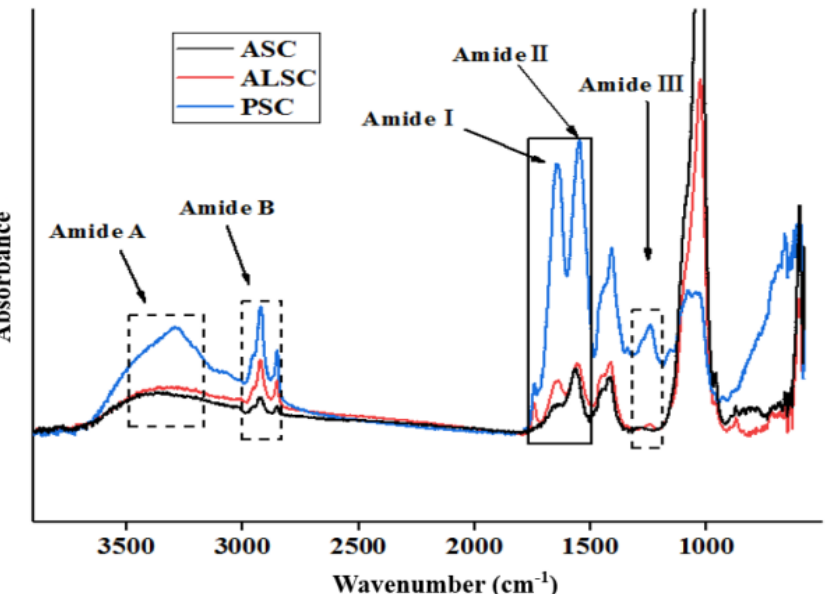
Figure 2. Fourier transform infrared spectra of ASC, ALSC, and PSC. Amide I bands and amide II bands, which are related to molecular order and the triple helical structure of collagen, are known as fingerprints of protein secondary structures and are generated by C=O stretching, N-H bending, and C-H stretching, respectively [38]. The amide I band is associated with C=O stretching vibrations along the polypeptide backbone or with COO-coupled hydrogen bonds and has a strong absorbance in the range of 1600 to 1700 cm − 1 . The amide I bands of ASC, AlSC, and PSC are 1644.51 cm − 1 , 1652.18 cm − 1 , and 1644.40 cm − 1 , respectively. The amide II band mainly reflects NH bend- ing and CN tensile vibration, which usually occurs in the range of 1550 to 1600 cm − 1 . In other words, the amide II band specifies the number of NH radicals that form hydro- gen bonds with the adjacent α -chain. Thus, the lower wavenumber of the amide II band indicates both an increased number of hydrogen bonds by the NH radical and a higher struc- tural order [39]. Amide II bands of ASC, AlSC, and PSC are 1559.72 cm − 1 , 1560.49 cm − 1 , and 1548.30 cm − 1 , respectively. Yousefi et al. [39] suggested that amide II bands of collagen located at low wavenumbers have more hydrogen bonds between adjacent α -chains. This evidence suggests that there are more hydrogen bonds in PSC. The absorption of amide III band is related to the triple helical structure of collagen, including C-N stretching, planar bending of C-H amide bonds, and the vibration of CH 2 radical on glycine main chain and proline side chain [40], and is typically located in the wavelength range of 1300 cm − 1 to 1200 cm − 1 . Amide III bands of ASC, AlSC, and PSC were 1244.24 cm − 1 , 1250.84 cm − 1 , and 1243.22 cm − 1 , respectively, indicating that there were stable triple helical structures in the three collagens. In addition, the three collagens had transmission peaks between 1400 cm − 1 and 1465 cm − 1 , which may be the pyrrole ring vibration of proline and hydroxyproline in collagen [40]. It has been reported that the intensity ratio of the amide II band and the 1450 cm − 1 band was used to elucidate the collagen triple-helix structure of collagen, and the transmission ratio of the amide III band to the 1400–1465 cm − 1 band is close to 1.0; the integrity of the triple-helix structure of the three types of collagens was confirmed [17,41]. Therefore, the complete triple-helix structure was still maintained in the ASC, ALSC,